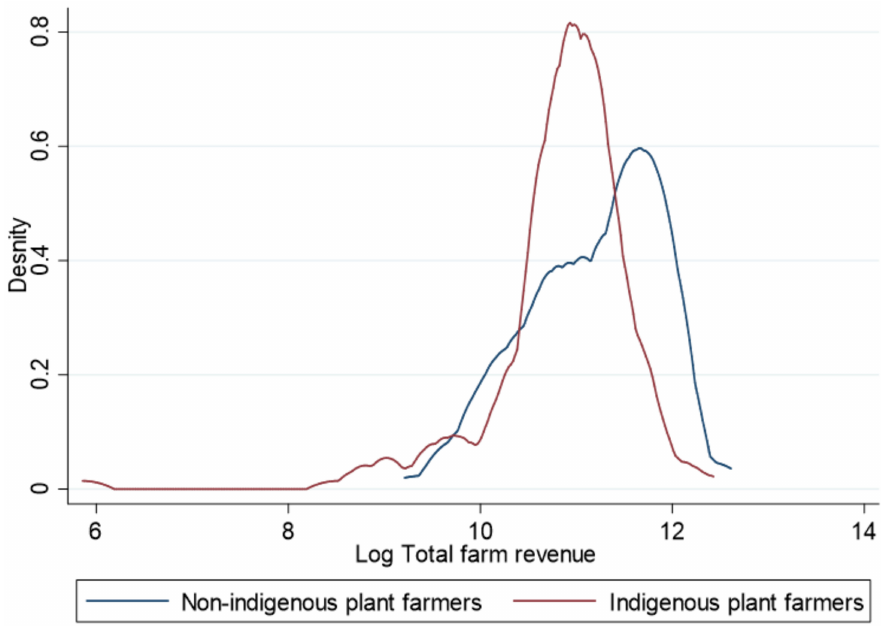
Figure 3. Kernel density distributions of total revenue disaggregated by land